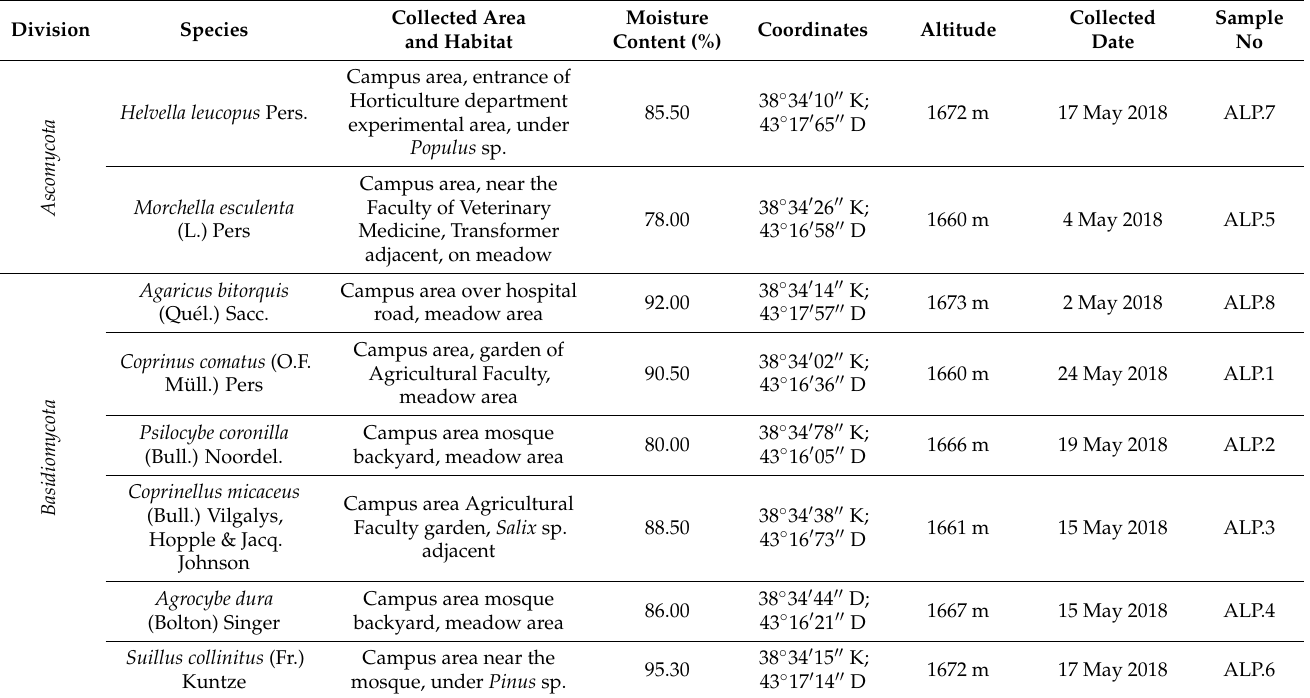
Table 1. Macro-fungi used in the